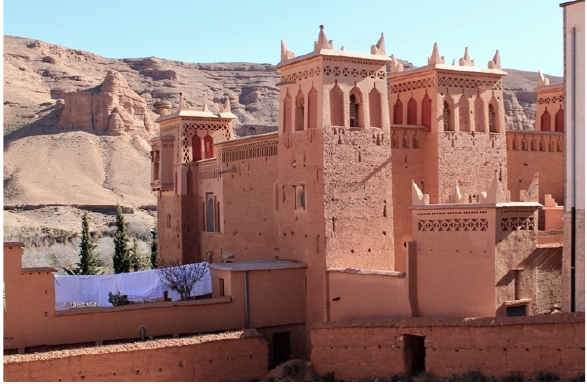
Figure 11. “Dar Jnan Tioura”, Tamellalt.